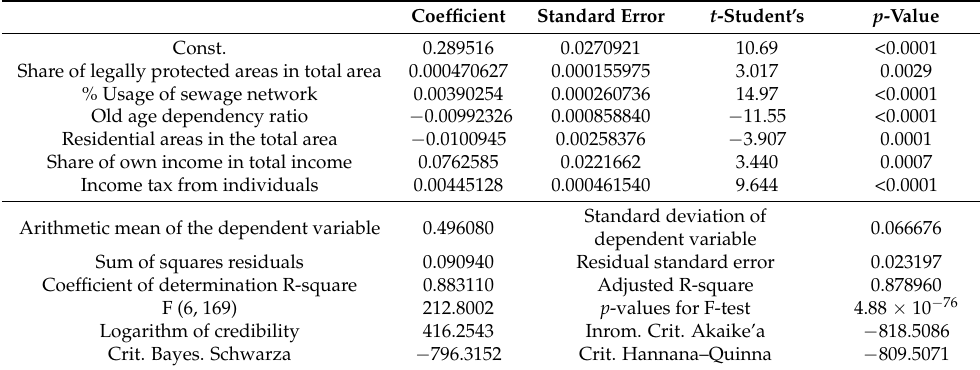
Table 6. Results of the regression analysis of the synthetic measure of the quality of life in voivodships in